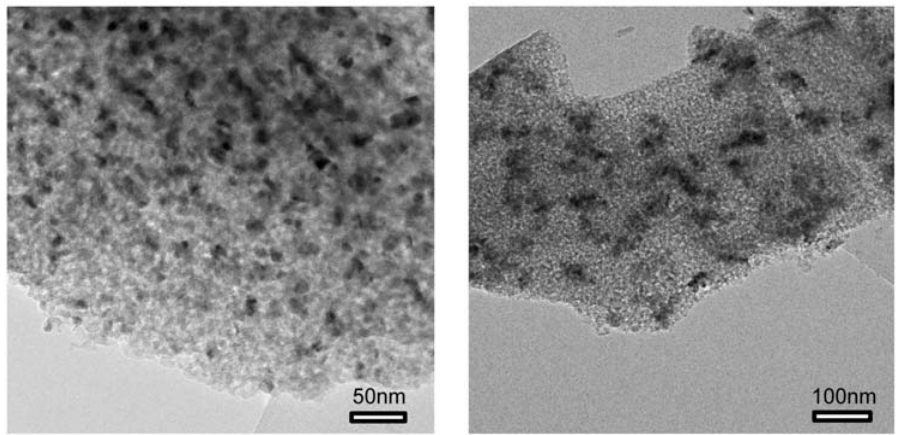
Figure 6. High Resolution Transmission Electron Microscopy (HRTEM) micrographs of the fresh Ni/Al 2 O 3 catalyst.